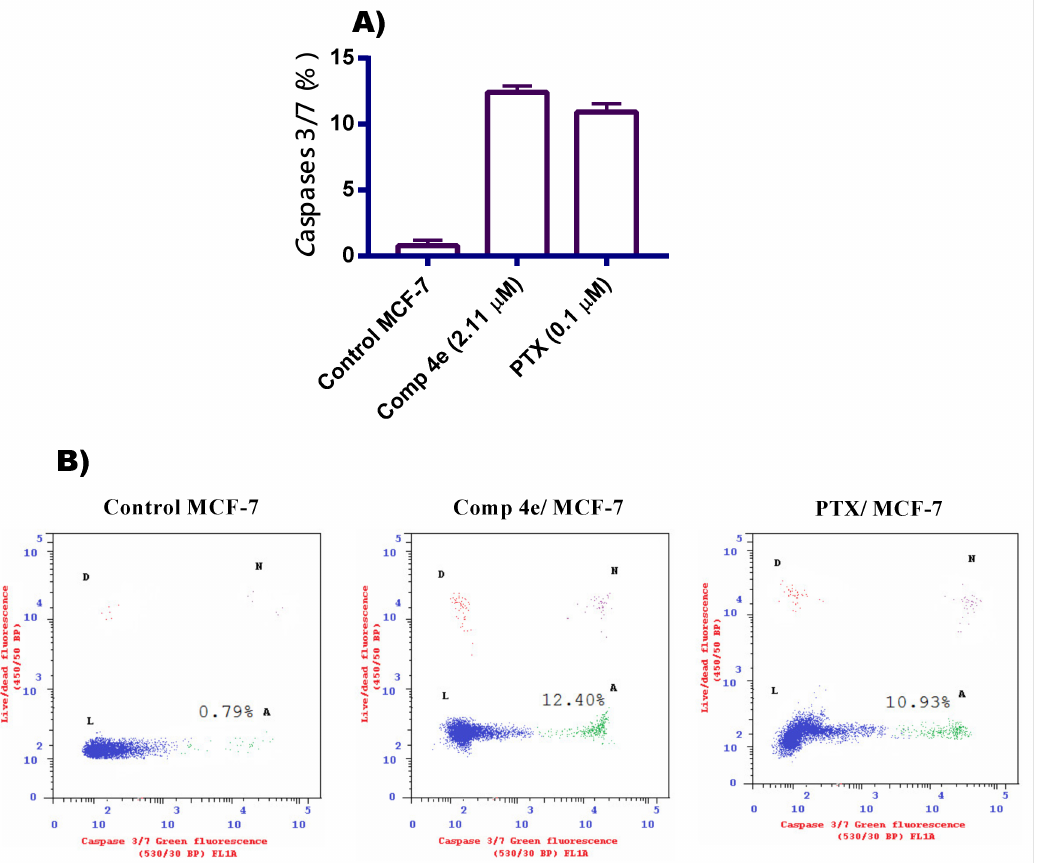
Figure 6. ( A ) Graphical representation of c aspase 3/7 analysis related to apoptosis of compound 4e and PTX compared with untreated control cells. ( B ) C aspase 3/7 analysis related to apoptosis of compound 4e and PTX compared with untreated control cells.